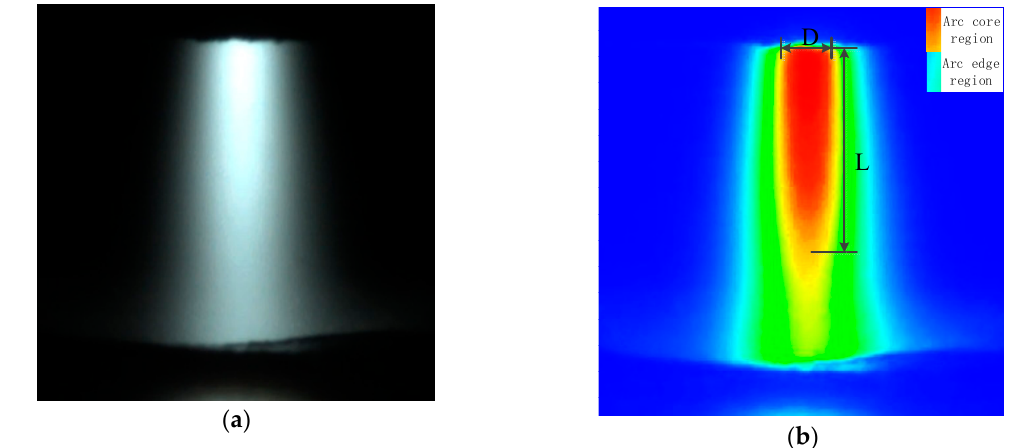
Figure 6. Edge extraction and regionalization of welding arc. ( a ) Original arc image; ( b ) processed arc image.